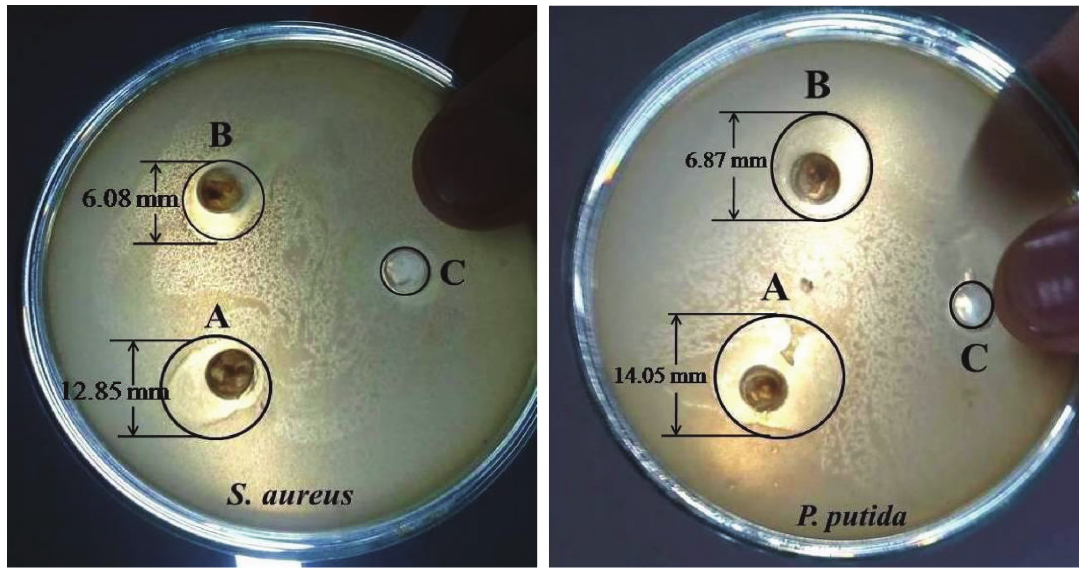
Figure 8: Result of antibacterial disc diffusion